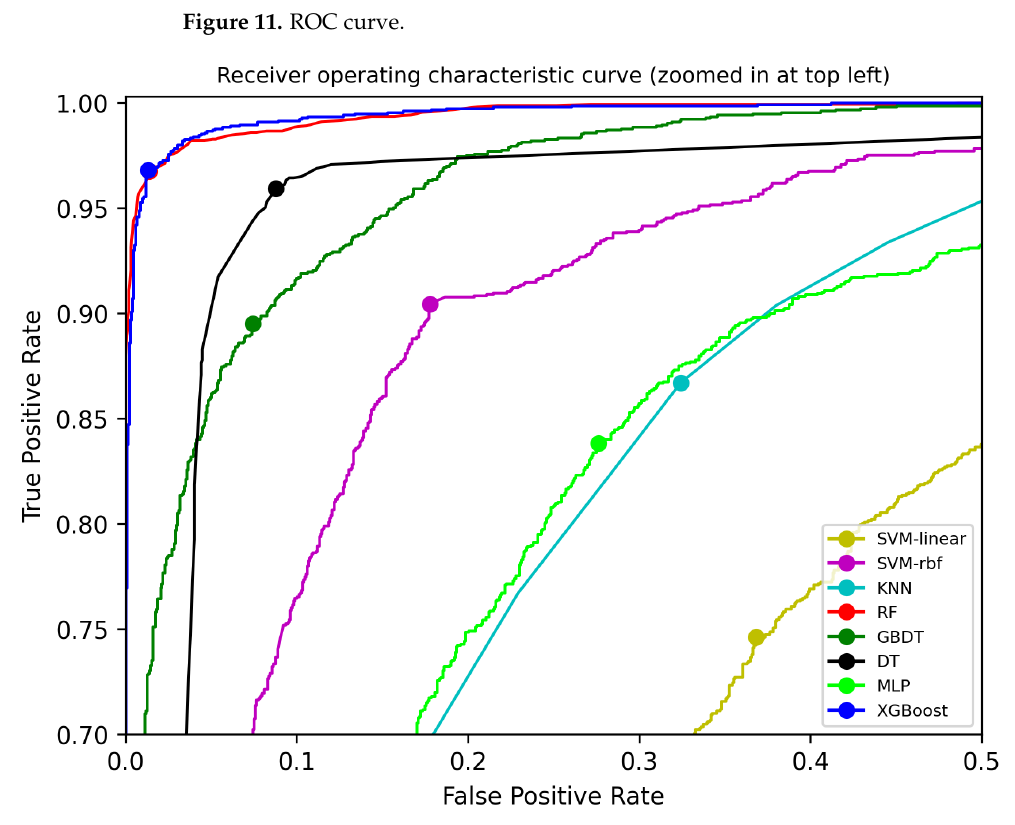
Figure 11. ROC curve.